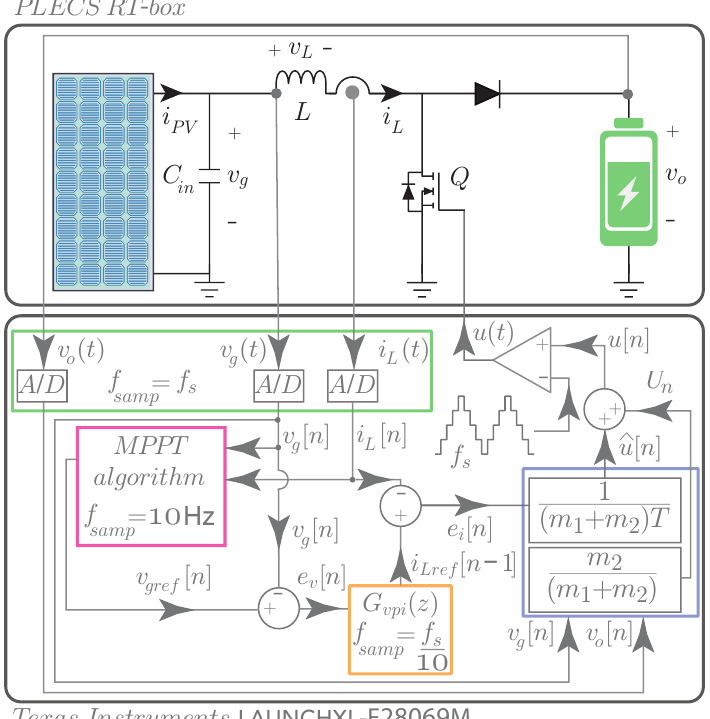
Figure 5. Block diagram of the digital controller for the MPPT of the boost